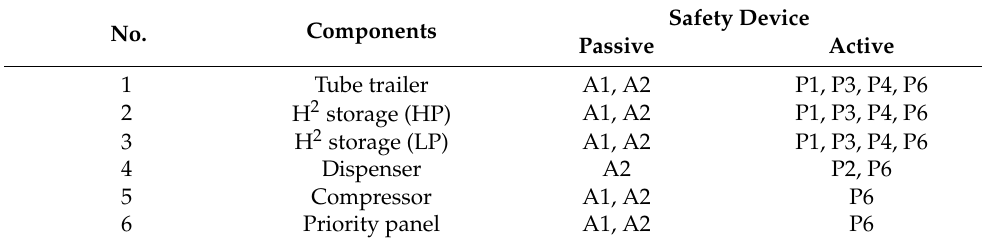
Table 6. Applied IPLs for each facility used to reduce the